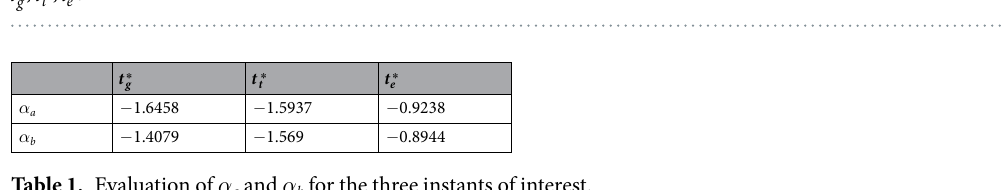
Table 1. Evaluation of α a and α b for the three instants of interest.